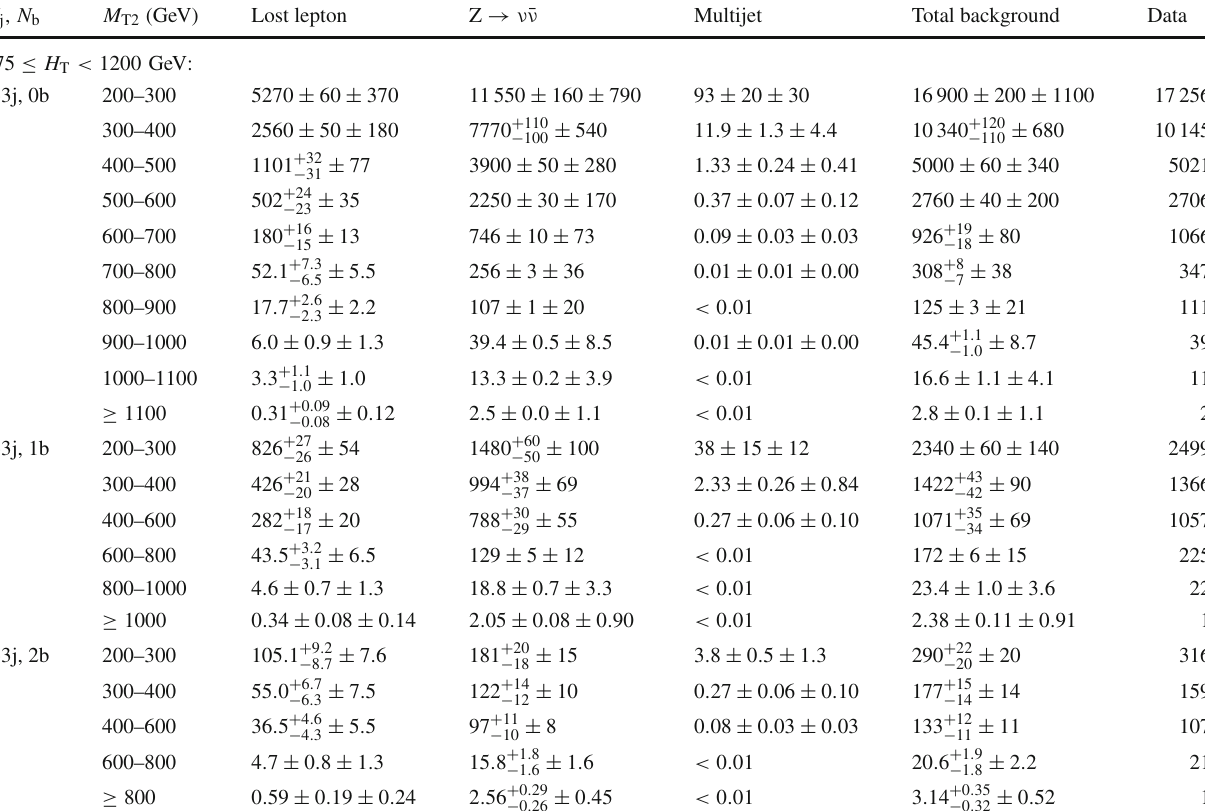
Table 16 Predictions and observations for the 21 search regions with 575 ≤ H T < 1200 GeV and 2 ≤ N j ≤ 3. For each of the background predictions, the first uncertainty listed is statistical (from the limited